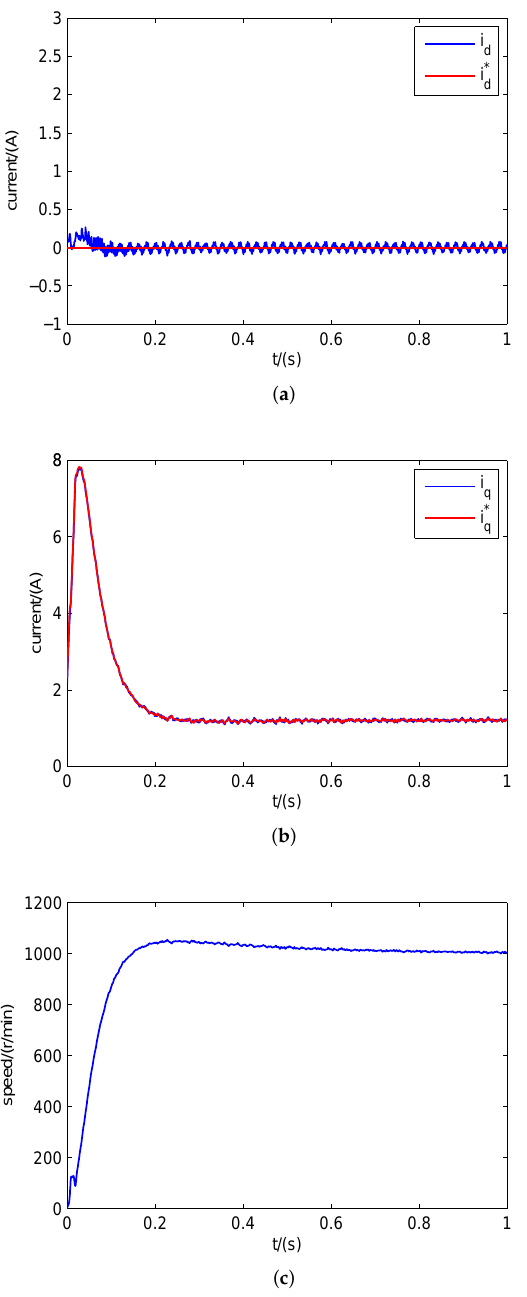
Figure 14. Experimental results with parameter variations: ( a ) d-axes current, ( b ) q-axes current, and ( c ) speed